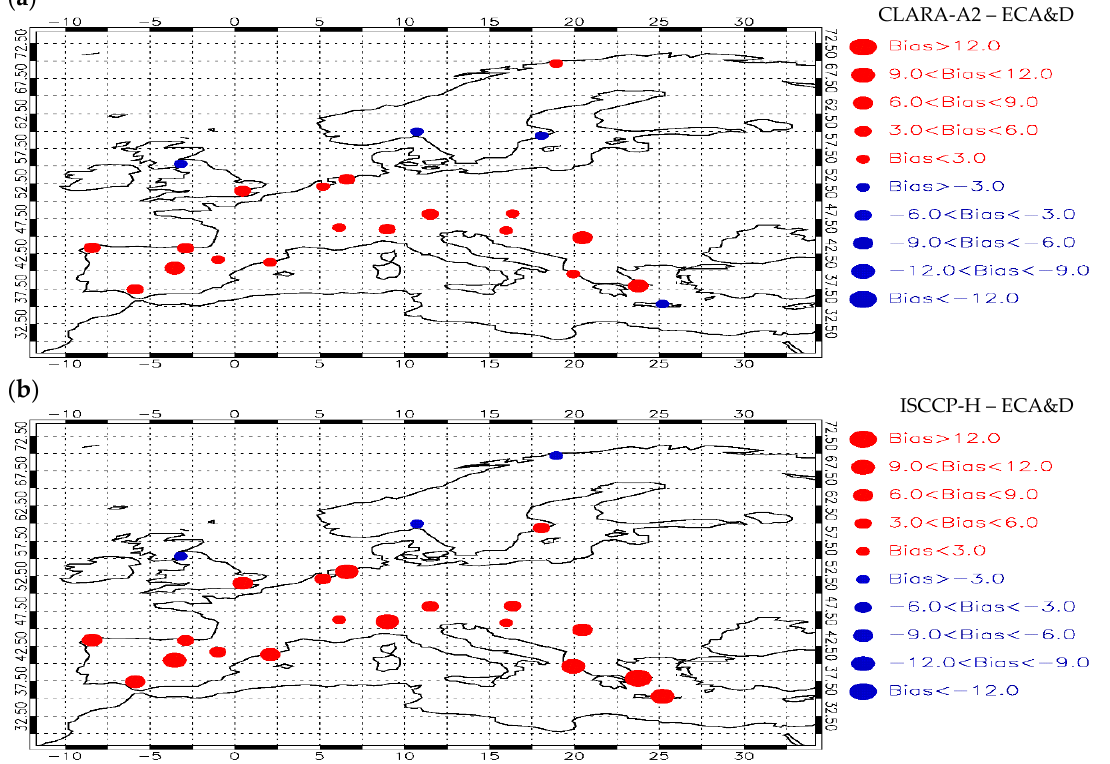
Figure 7. Same as in Figure 5, but for the TCC bias value (in percent). Table 4 . Mean Absolute Error (MAE) and Root Mean Squared Error (RMSE), both in percent cloud cover, for the comparison between CLARA-A2 and ISCCP-H against ECA&D stations.